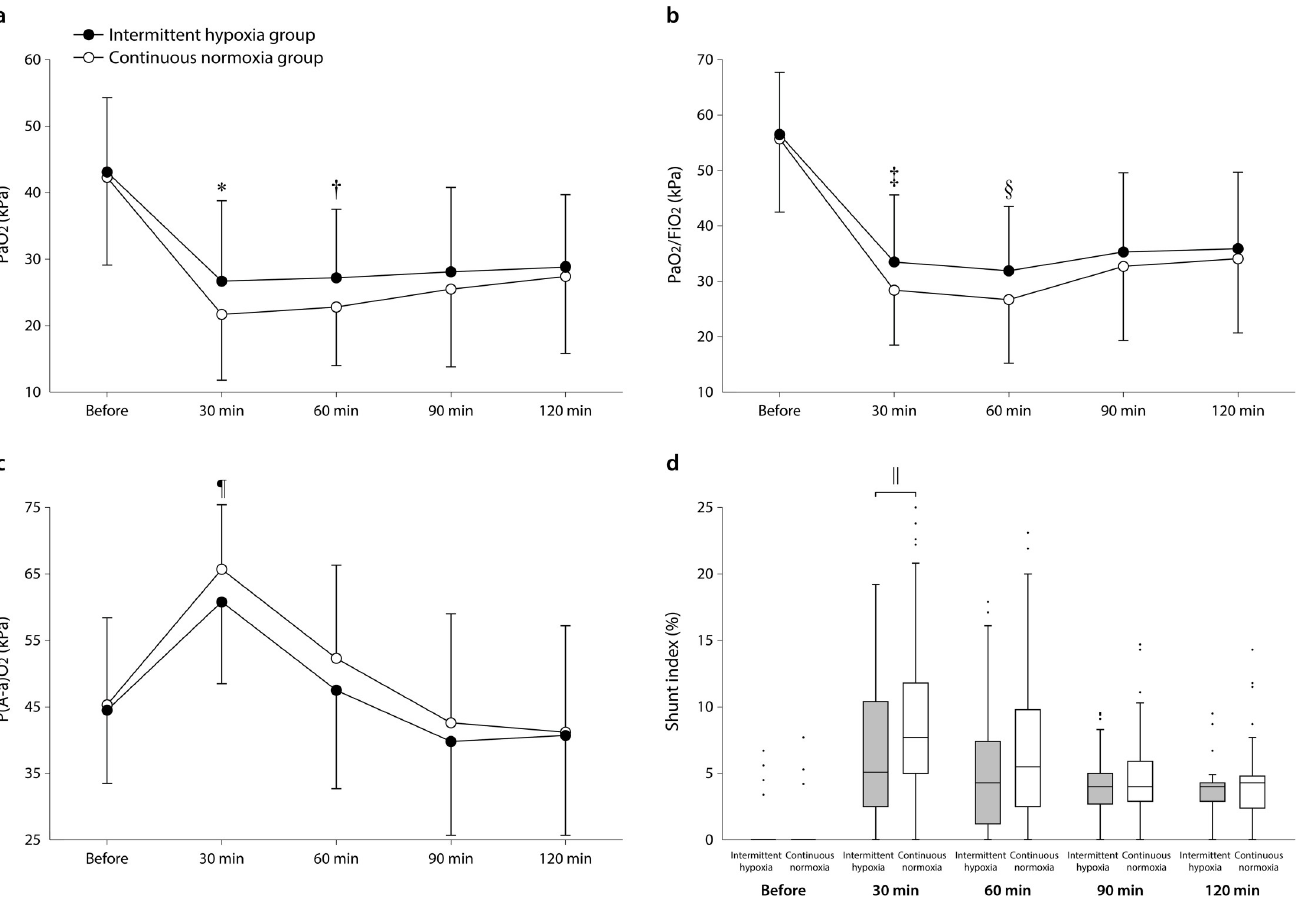
Fig 3. PaO 2 (a), PaO 2 /FiO 2 (b), alveolar-arterial oxygen pressure gradient [P(A-a)O 2 ; c], and shunt index (d) before and 30, 60, 90, and 120 min after starting one- lung ventilation. The circles and error bars are mean and standard deviation. � mean difference (95% CI) 5.0 (1.3–8.8) kPa, P = 0.008; † 4.4 (1.2–7.6) kPa, P = 0.007; ‡ 5.0 (1.3–8.8) kPa, P = 0.008; § 5.3 (1.3–9.2) kPa, P = 0.008; ¶ 4.9 (-8.8 to -1.2) kPa, P = 0.010; k median (interquartile range) 5.1% (2.5–10.4%) vs 7.7% (5.0–11.8%), P =